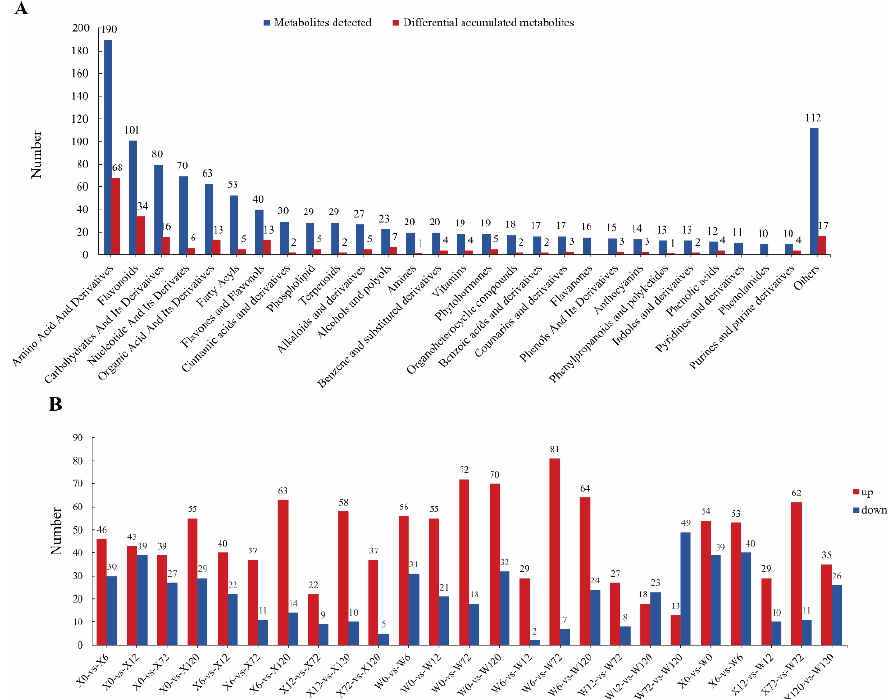
Figure 2. Number of metabolites histogram, ( A ): All metabolites are classified in blue and their amounts, red is the number and classification of DMs; ( B ): differential metabolites of 25 comparison groups, up-regulated in red and down-regulated in blue.